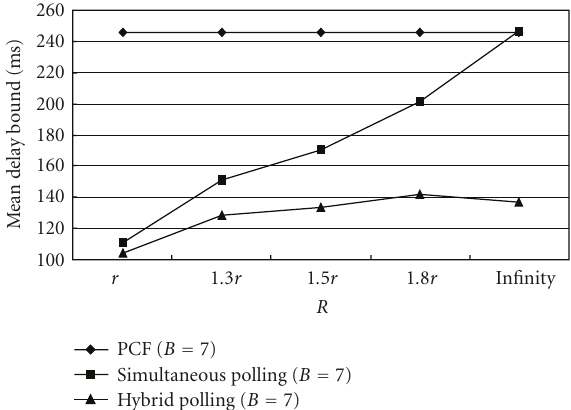
Figure 8: Mean delay bounds when the medium tra ffi c load ( B = 7) is imposed on IEEE 802.11a wireless LAN with 30